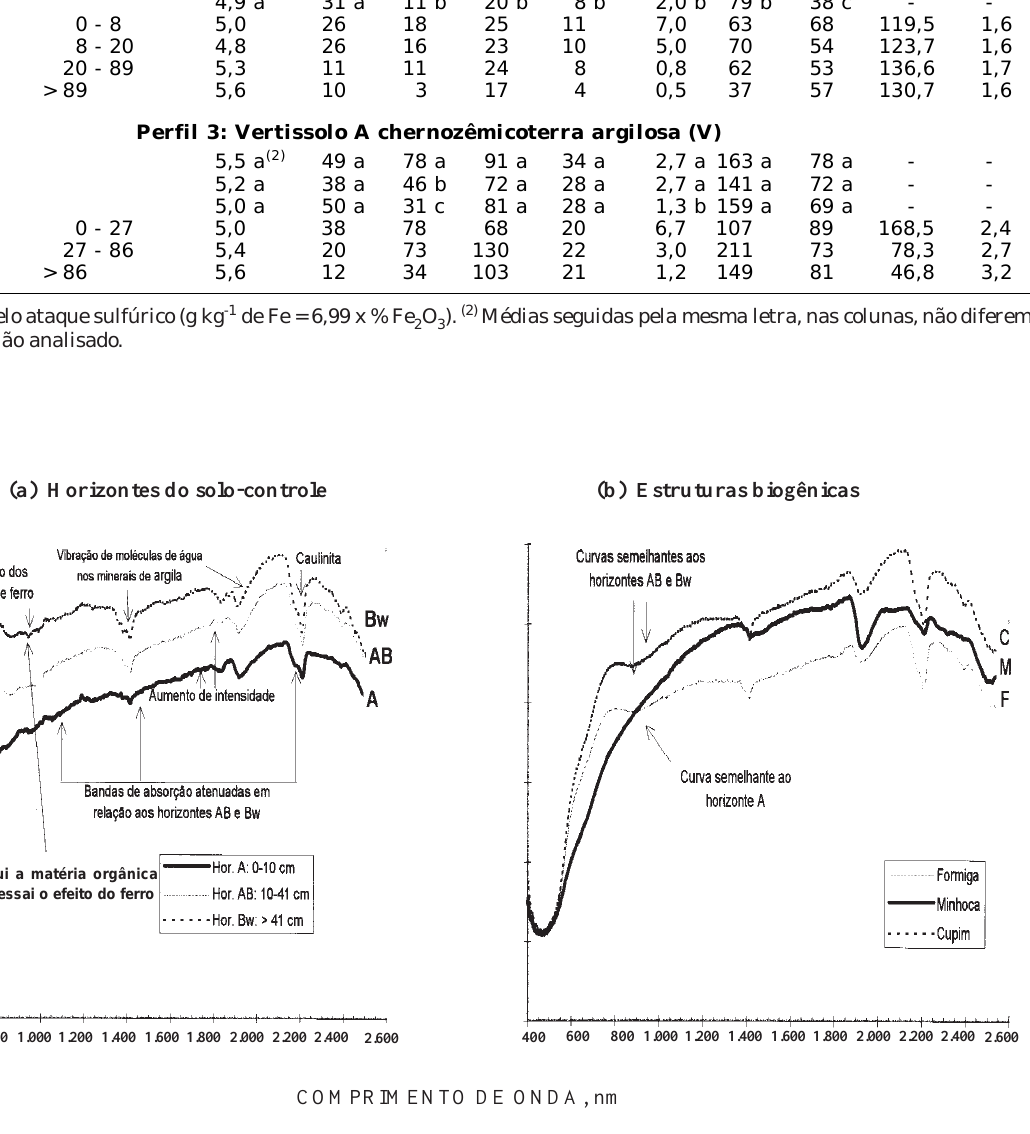
Figura 4. Comportamento espectral dos horizontes do Latossolo Vermelho-Amarelo (a) e das estruturas biogênicas